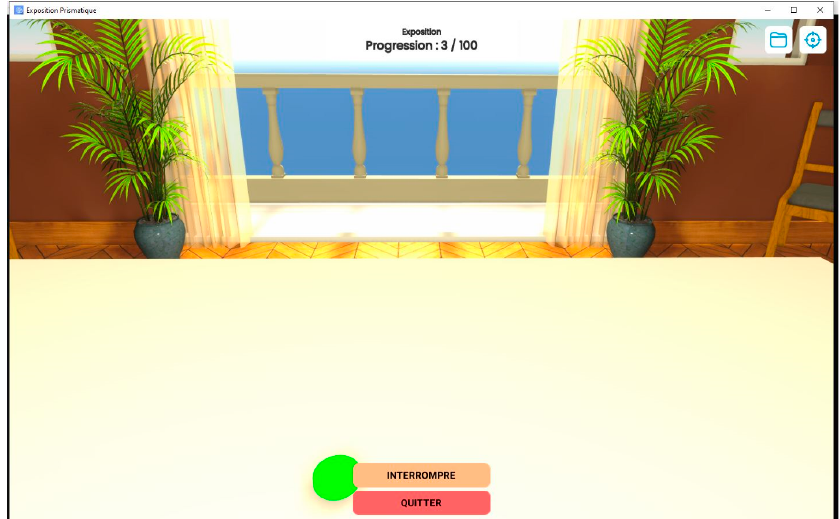
Figure 4. Interface of the Virtualis game. The participant visualizes the scene with a 10° deviation to the right. A green target is shown here, located at 17° to the left. When the participant points at the target, a new target will appear randomly on the left or right.